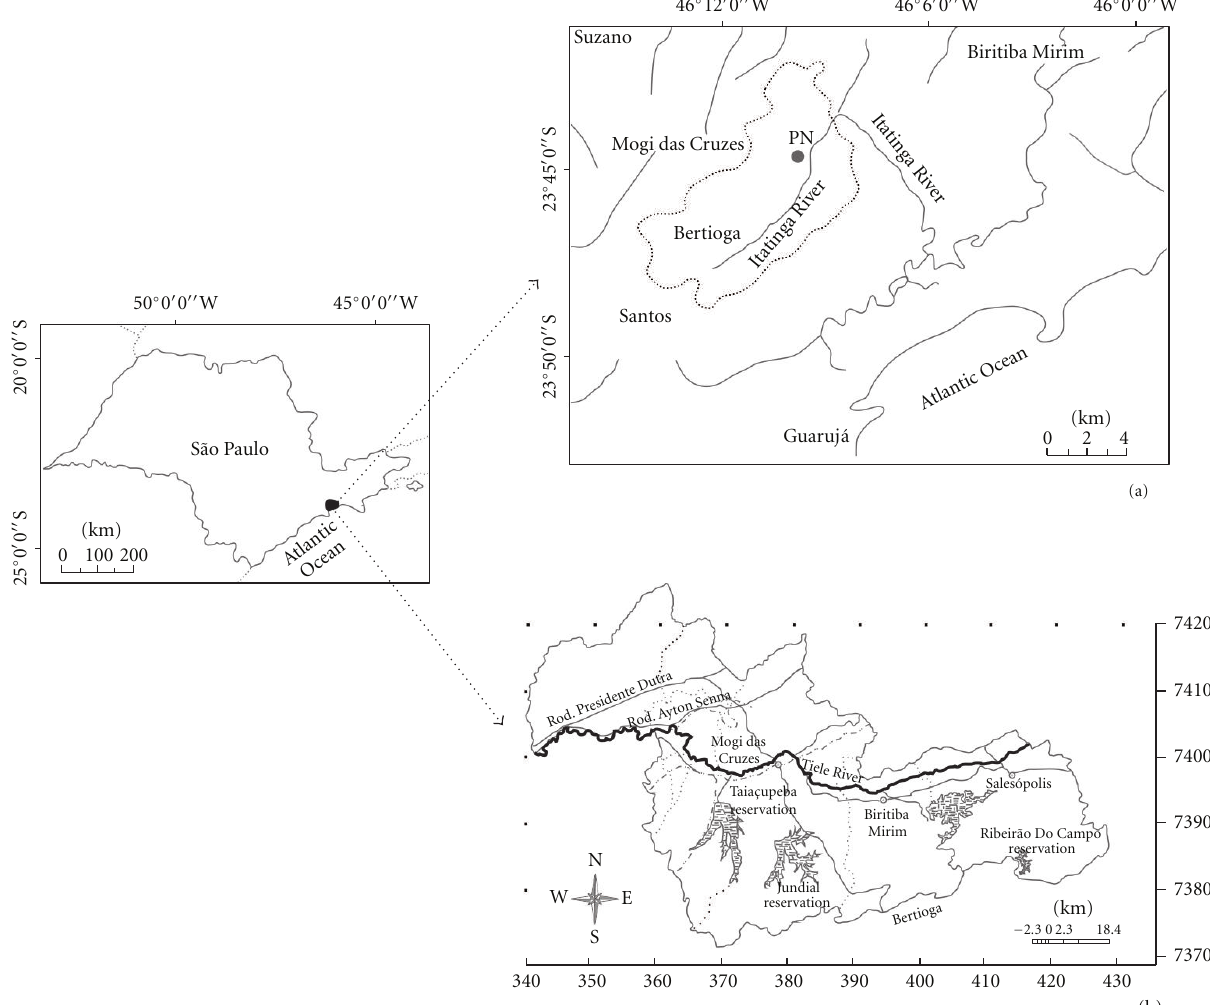
Figure 1: Location of the Itatinga (a) and Upper Tietˆe (b) river watersheds where the samples were